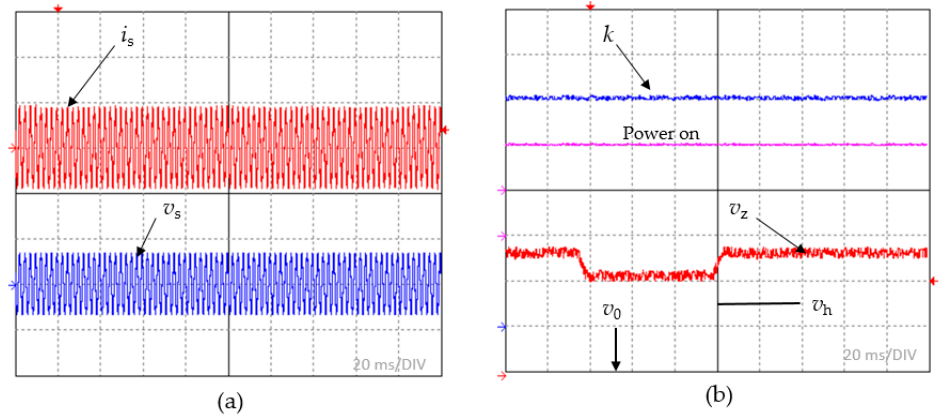
Figure 10. Dynamic response of the system to a voltage change on power bus 4: ( a ) waveforms of